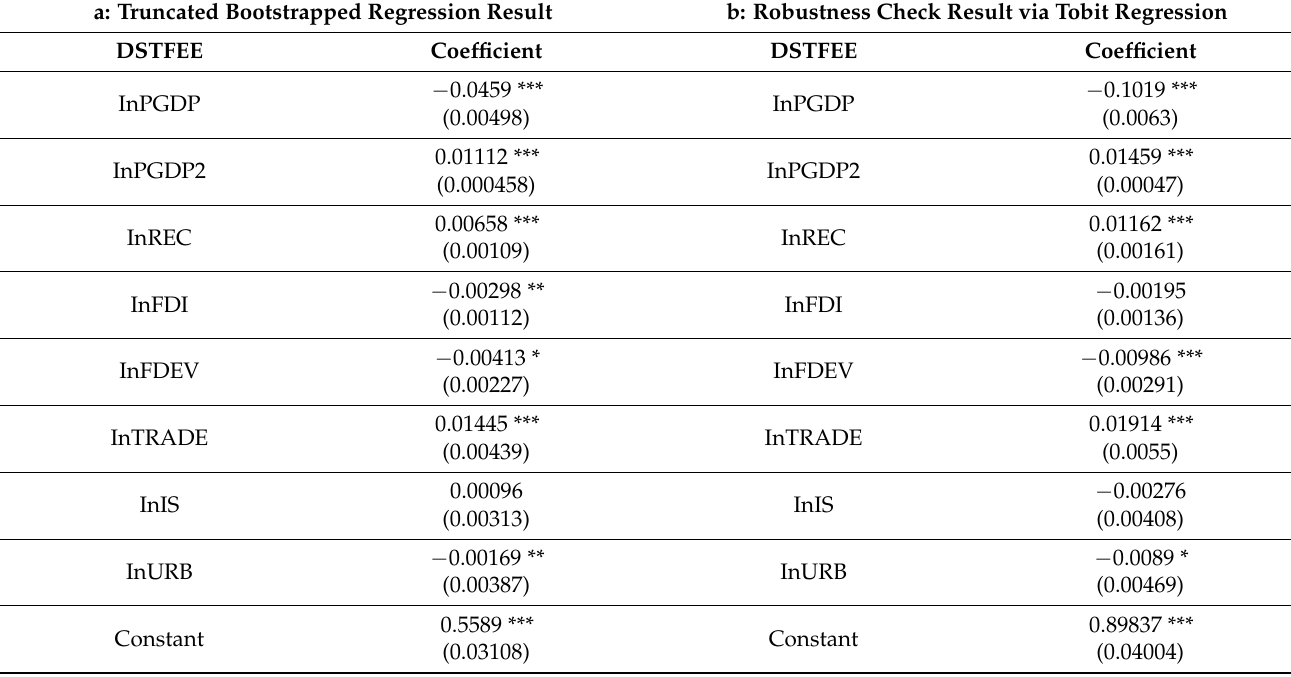
Table 9. Results of determinants of dynamic ecological efficiency in